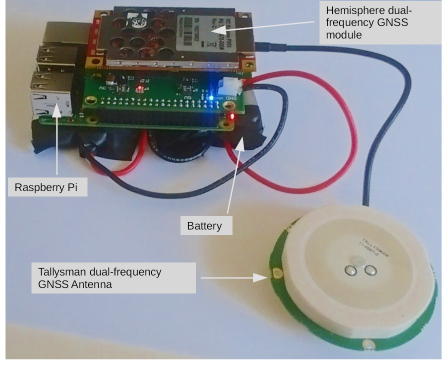
Figure 13: Dual-frequency GNSS